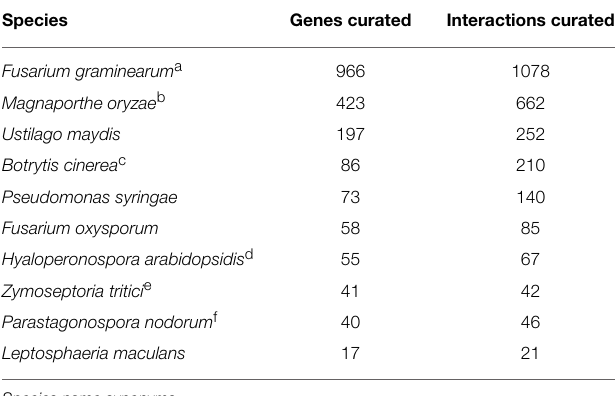
TABLE 1 | Top 10 plant pathogen species in PHI-base. Species Genes curated Interactions